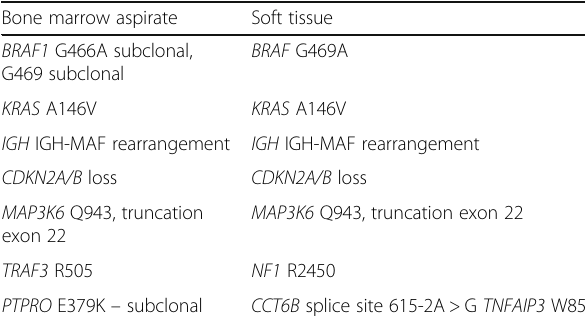
Table 1 Next-generation sequencing of the diagnostic bone marrow aspirate and left gingival lesion Bone marrow aspirate Soft tissue BRAF1 G466A subclonal, G469 subclonal